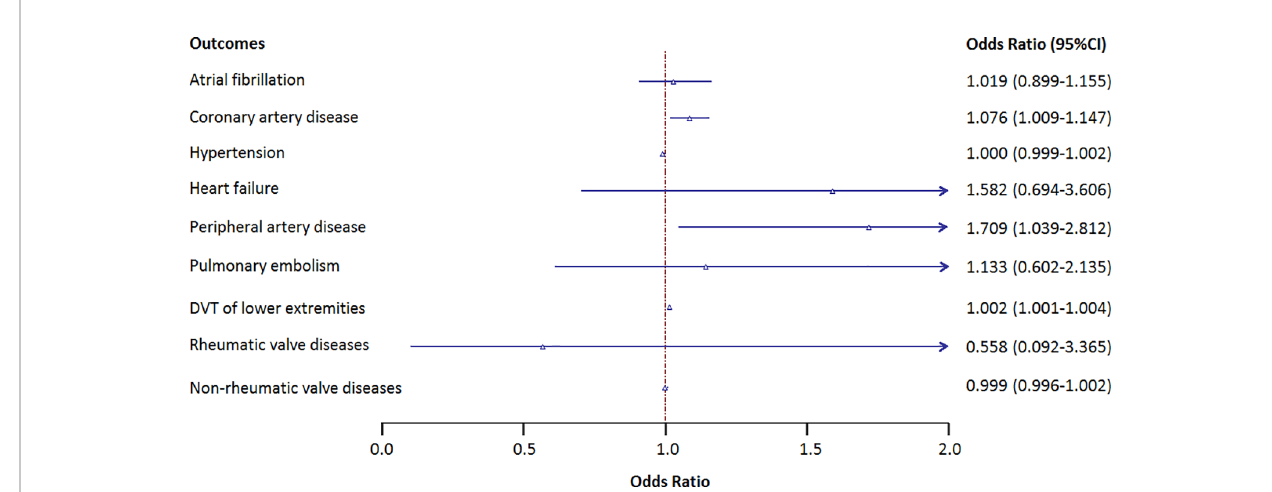
FIGURE 2 | Results of the Mendelian randomization analysis investigating the association of genetically proxied anti-cytomegalovirus IgG levels and risk of 9 cardiovascular diseases. Forest plot showing inverse variance-weighted Mendelian randomization estimates for the association between anti-cytomegalovirus IgG levels and risk of 9 cardiovascular diseases. DVT, deep vein thrombosis; OR, odds